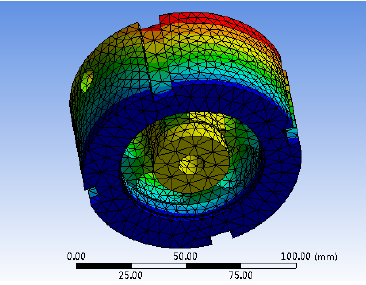
Figure 11. The resonance frequency of the first-order modal.